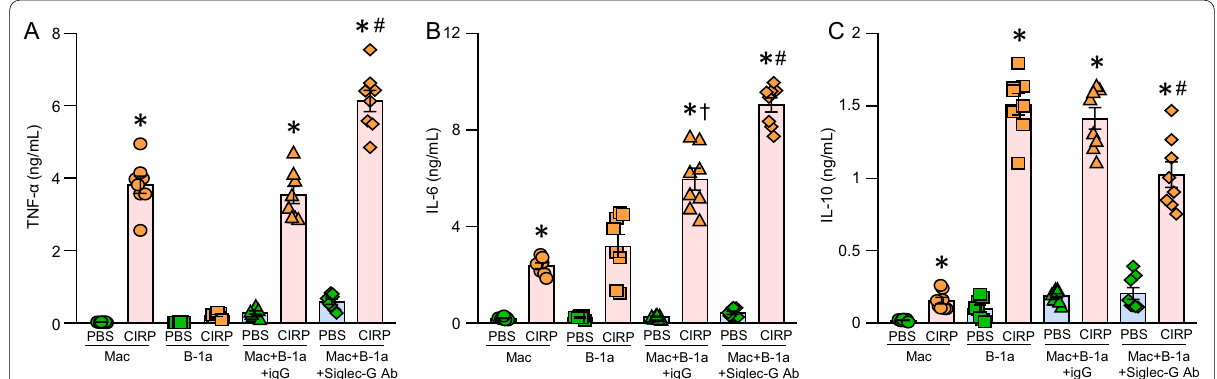
Fig. 6 Neutralizing Siglec-G in B-1a cells causes more TNF-α, and IL-6 and less IL-10 production in rmCIRP-treated macrophage co-cultures. PerC macrophages were co-cultured with B-1a cells that had been pretreated with Siglec-G blocking Ab or IgG control and then stimulated with rmCIRP or PBS vehicle for 24 h. Supernatant A TNF-α, B IL-6, and C IL-10 concentration were assessed with ELISA. Data are expressed as means mice/group) and compared by one-way ANOVA and Student–Newman–Keuls (SNK) method (*p < 0.05 vs. PBS stimulated macrophages, # p < 0.05 vs. macrophages cultured with IgG treated B-1a cells stimulated with rmCIRP, † p < 0.05 vs. untreated B-1a cells stimulated with